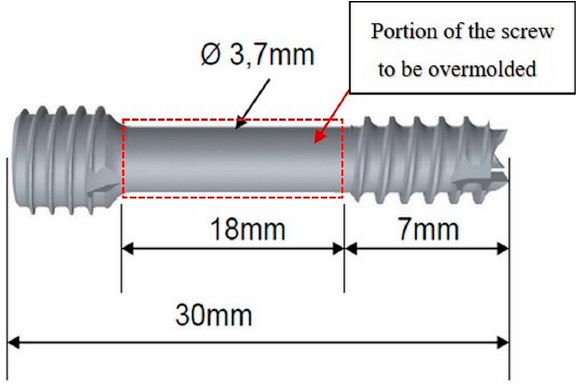
Figure 1. Headless compression screw and its dimensions.